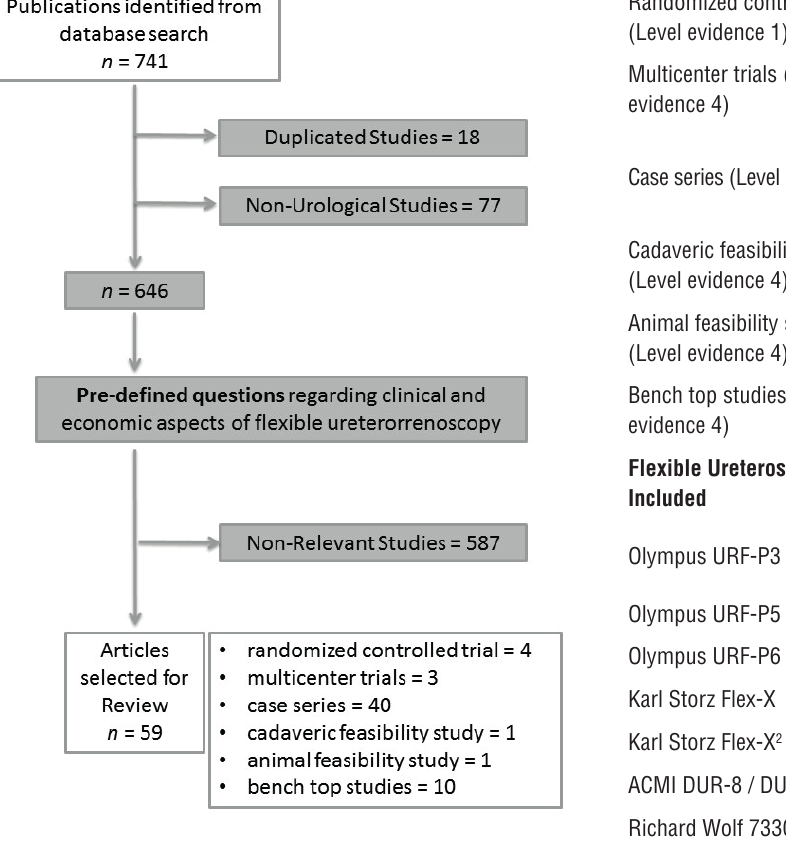
Table 1 – Study details regarding design and type of flexible ureteroscope